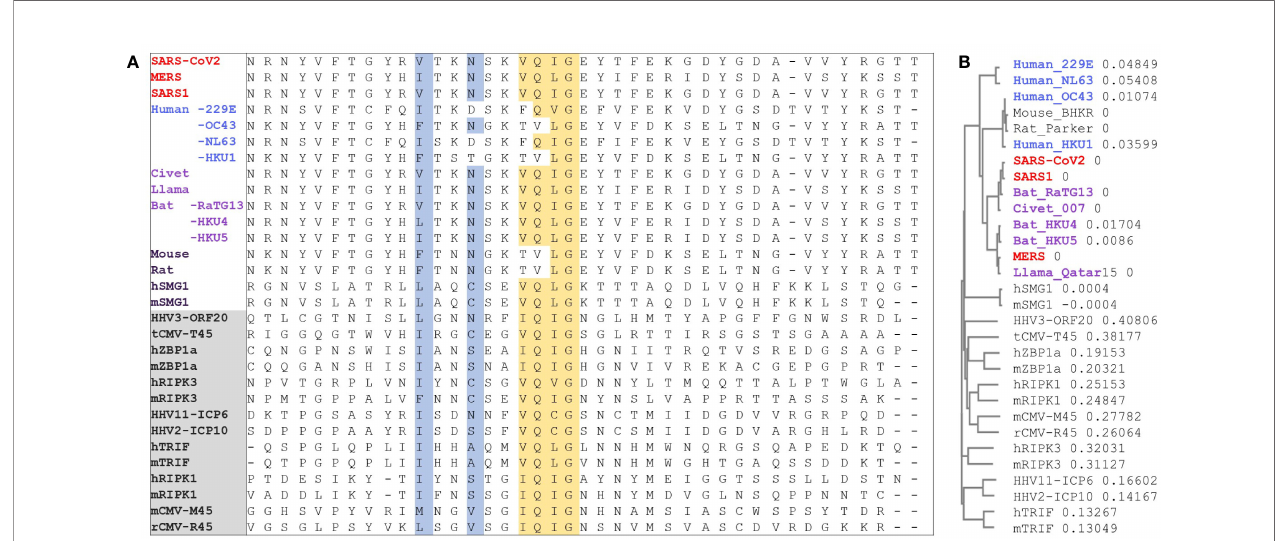
FIGURE 4 | RIP homotypic Interaction motif. (A) CoV Nsp13 protein sequences from different strains that contain the RHIM (I/V)Q(I/L/V)G residues (in yellow) were aligned with known RHIMs from other viral and host proteins (labels in the gray box). SMG1 was identi fi ed here but is not yet a validated RHIM. Residues are colored as in Figure 1. (B) Phylogram to show the sequence variation between proteins as a proportion. (HHV, human herpes virus; CMV, cytomegalovirus; ZBP1, Z-DNA binding Protein 1; RIPK, Receptor Interacting Protein Kinase; TRIF, Toll like Receptor Adaptor Molecule; SMG, SMG1 nonsense mediated mRNA decay associated